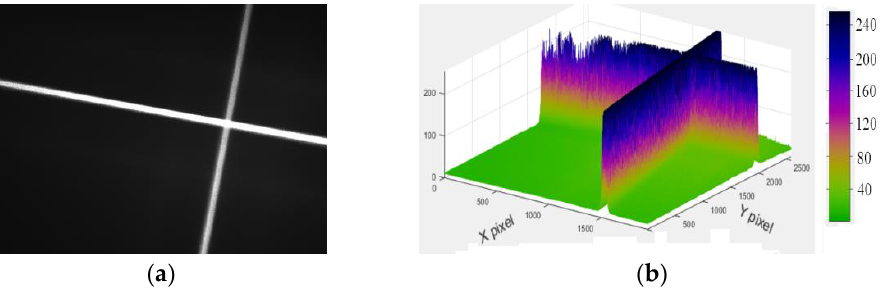
Figure 4. (a) Digital image of cross laser-pattern under simulated smoke and water mist environment. (b) Energy distribution of corss laser-pattern under the influence of smoke and water mist.